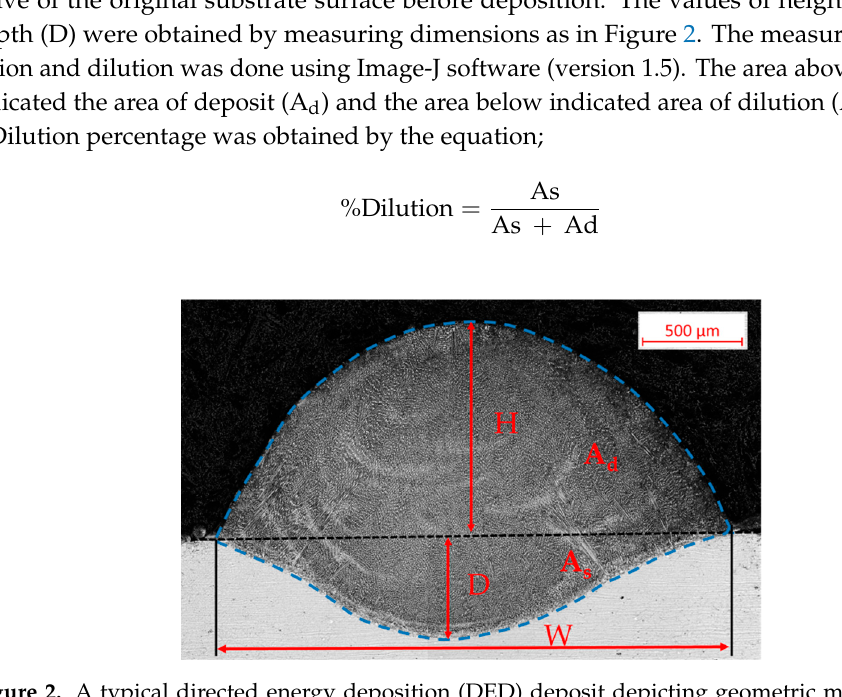
Figure 2. A typical directed energy deposition (DED) deposit depicting geometric measurements of interest.